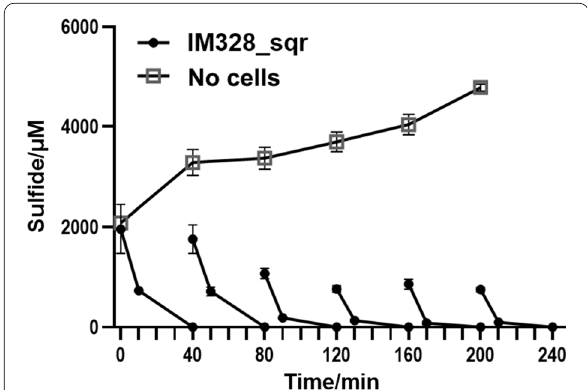
Fig. 7 The sulfide oxidation activity of IM328_sqr during six cycles of recycling. The experiments were carried out in a 15 mL centrifuge tube. Cells were resuspended at OD 600 of 2 in 10 mL of 25 mM CHES buffer (pH 9.0) at 37 °C, 200 rpm. Na 2 S was added to 2000 µM to initiate the reaction in each cycle and was completely oxidized within 40 min. The process of sulfide oxidation was performed for 40 min. The remaining sulfide levels of the reaction system were detected after ten minutes of each cycle. Controls consisted of the same buffer without bacterial